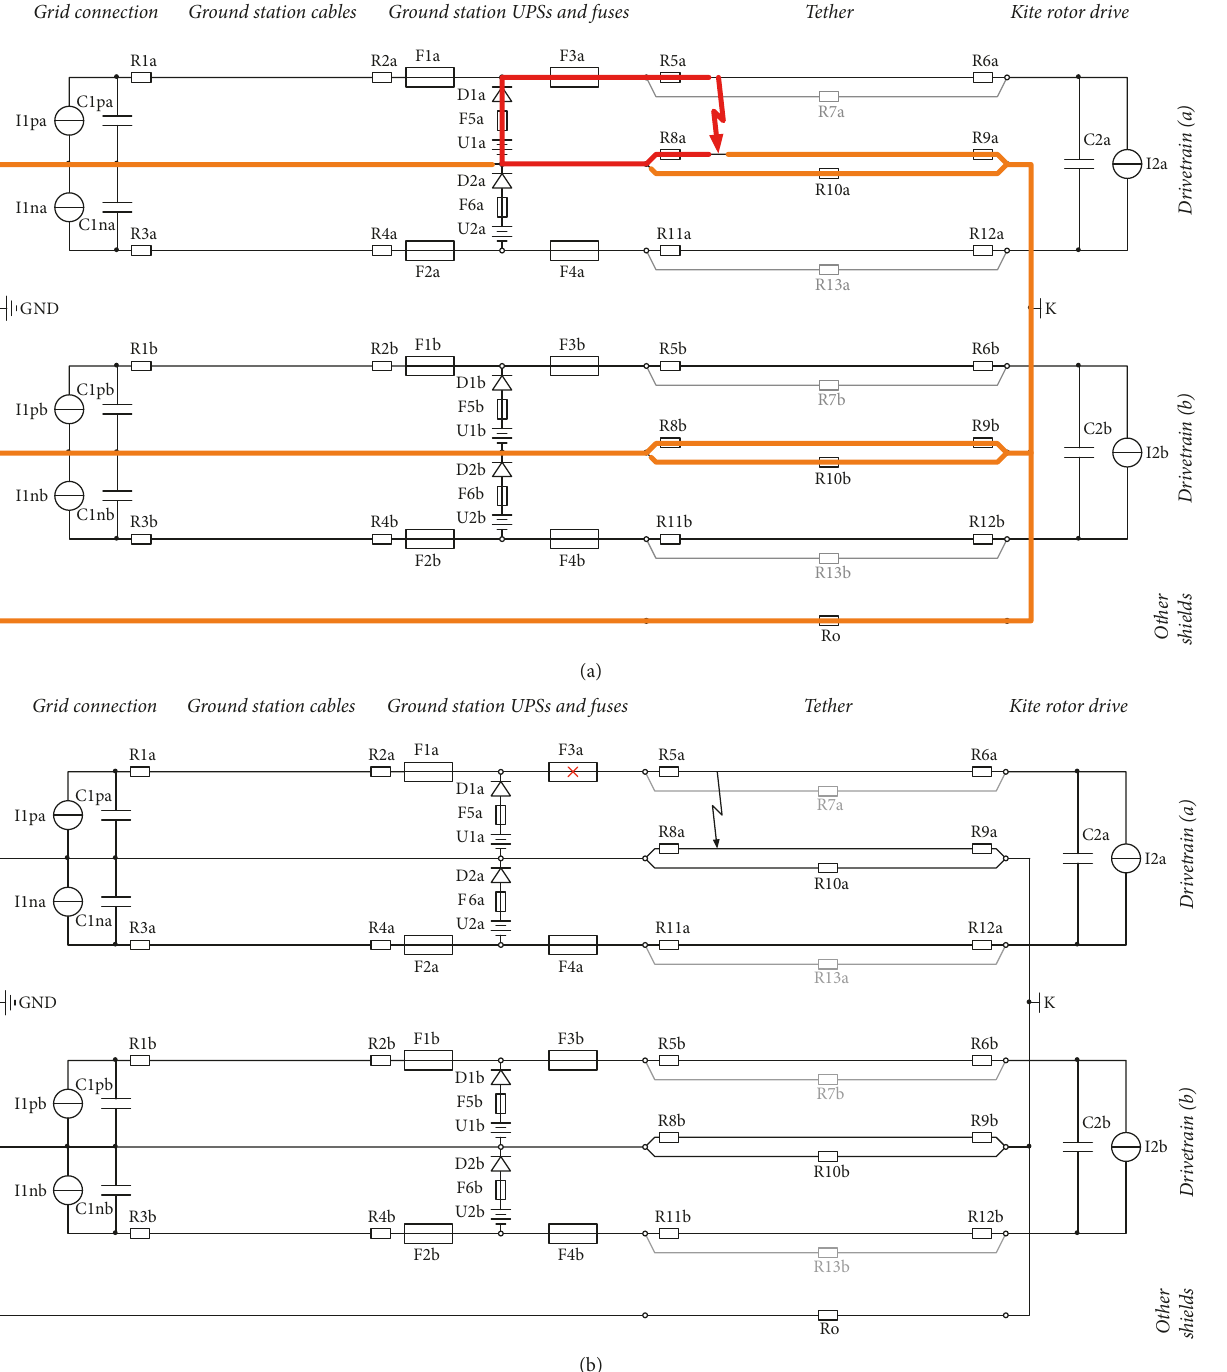
Figure 17: Investigation of short circuit fault S2: (a) short circuit currents driven by UPS(s) over different paths (different colors) and (b) circuit after fuse